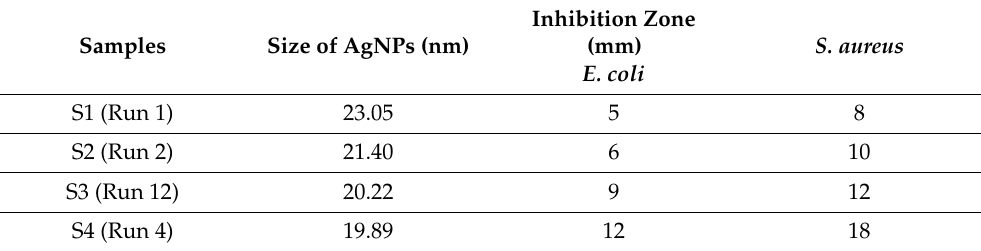
Table 5. The antibacterial activities and zones of inhibition of optimized AgNPs.